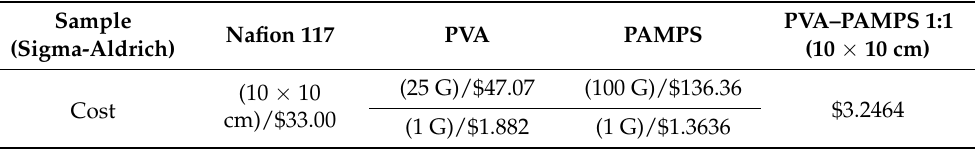
Table 3. Cost of Nafion 117, pristine PVA, PAMPS, and PVA:PAMPS (1:1) blend-based membranes.